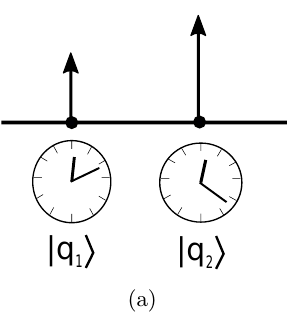
Figure 6 . (a) In the general relativity, one can evolve a state de(cid:12)ned on a Cauchy surface such that clocks at di(cid:11)erent locations in space run at di(cid:11)erent rates. This freedom of choosing space dependent lapse of time gives rise to the multi-(cid:12)ngered time evolutions. In the (cid:12)gure, represent the clock degrees of freedom localized at sites 1 and 2 respectively. (b) In the present theory, there is a larger gauge freedom. One not only has a freedom to choose di(cid:11)erent rates for a given set of clocks, but also has a freedom to construct a whole di(cid:11)erent set of clocks out of degrees of freedom de(cid:12)ned at multiple sites through linear superpositions. This extra freedom is encoded in the o(cid:11)-diagonal elements of the lapse tensor that rotates frame in eq. (3.21). In priori, there is no preferred frame in which the clocks are de(cid:12)ned. In order to de(cid:12)ne a time evolution in a meaningful way, one has to de(cid:12)ne a set of clocks out of physical degrees of freedom within the theory and describe evolution of other degrees of freedom relative to the local evolution of the physical